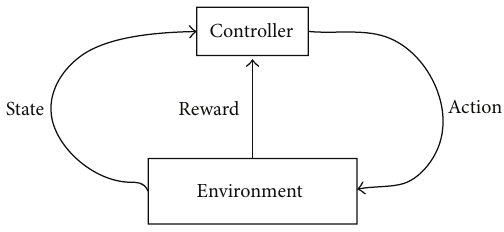
Figure 1: Framework of reinforcement learning. Controller selects an action; the environment responds to the action, generates new scenes to the agent, and then returns a